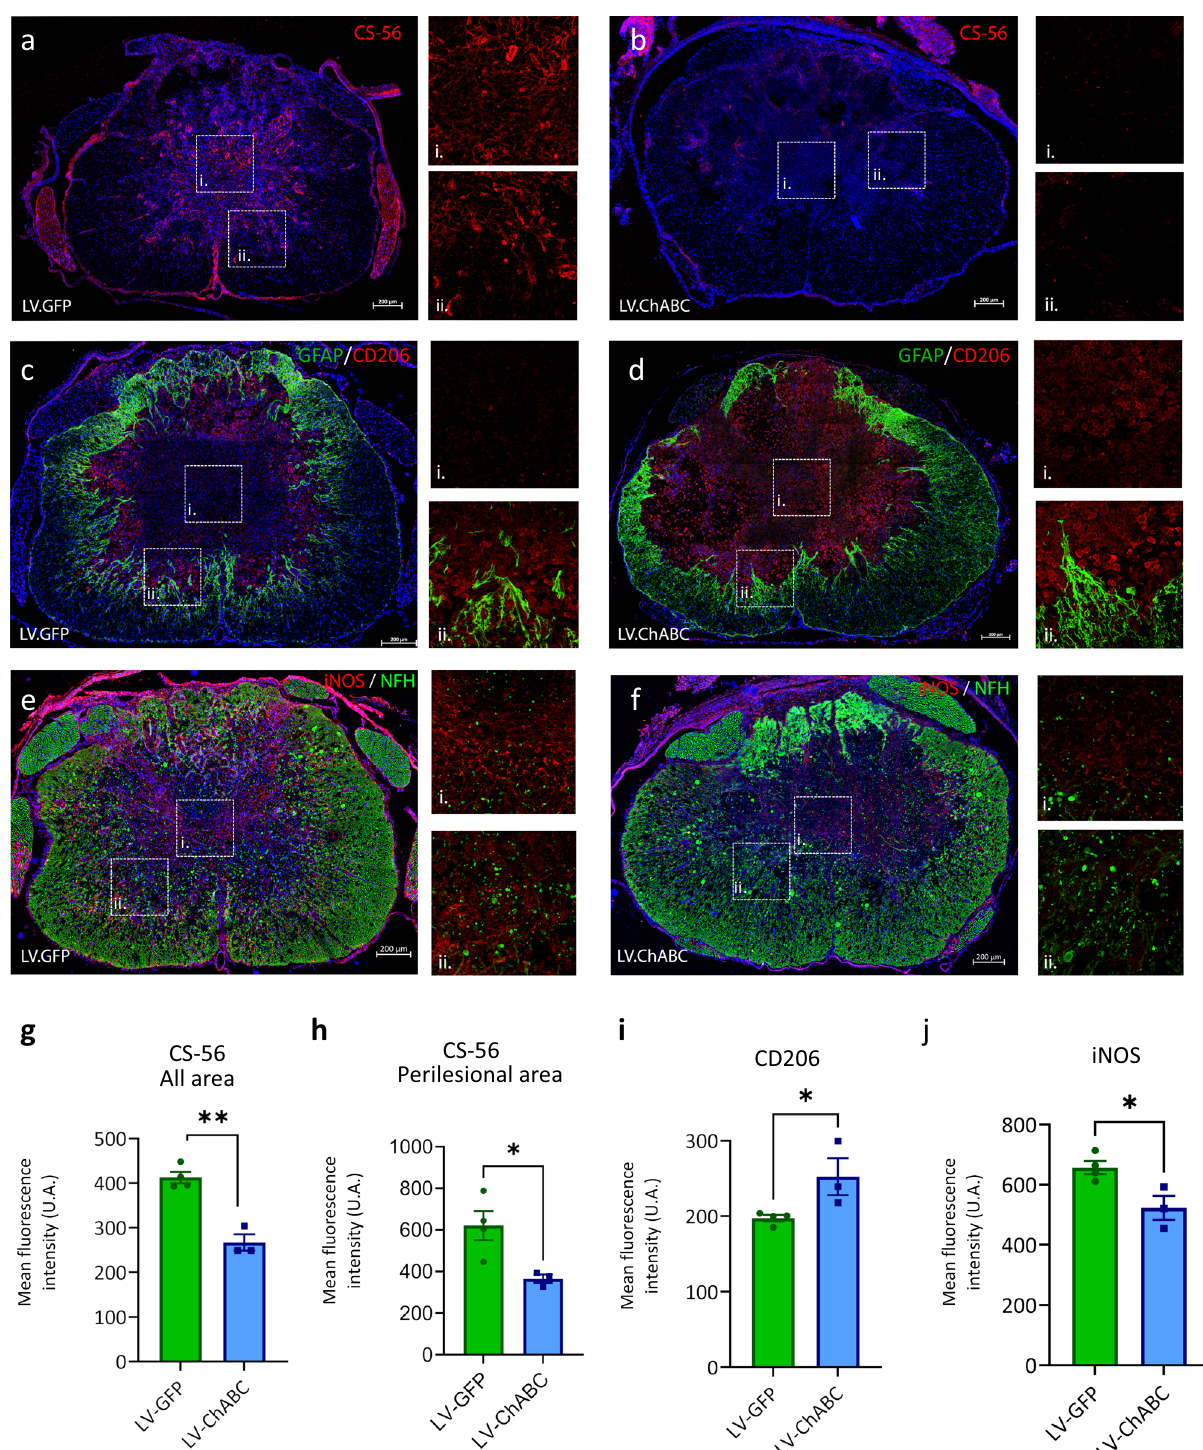
stimulated with CSPGs (Extended Data Fig. 8). Thus, at both a gene expression level and a functional level, CSPG stimulation makes M2-like macrophages more similar to M1-like macrophages. These data indicate that, in vitro, CSPGs have differential effects on macrophage phenotypes and a striking ability to convert pro- resolving macrophages to pro-in fl ammatory. Taken together with our in vivo fi ndings, where positive immunomodulatory effects of CSPG digestion after SCI are prominent at the resolution phase, when it is important that macrophages undergo a phenotypic